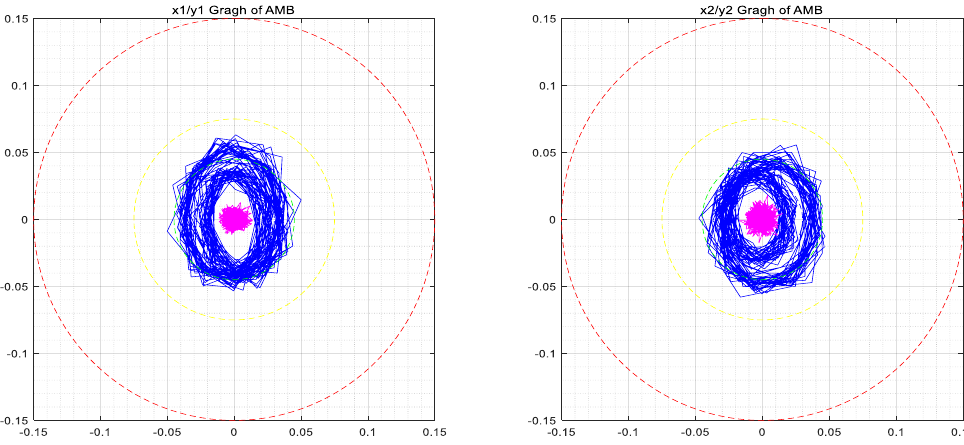
Figure 11. The AMB rotor’s axis loci of the places’ installed displacement sensors with and without the ILC.